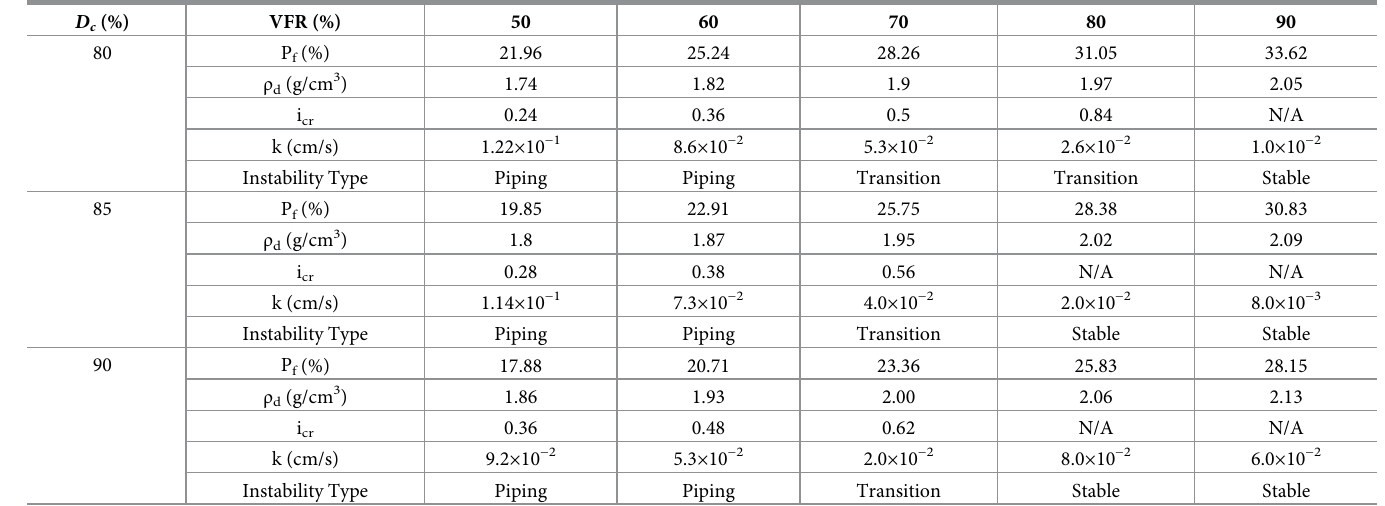
Table 1. Classification of soil